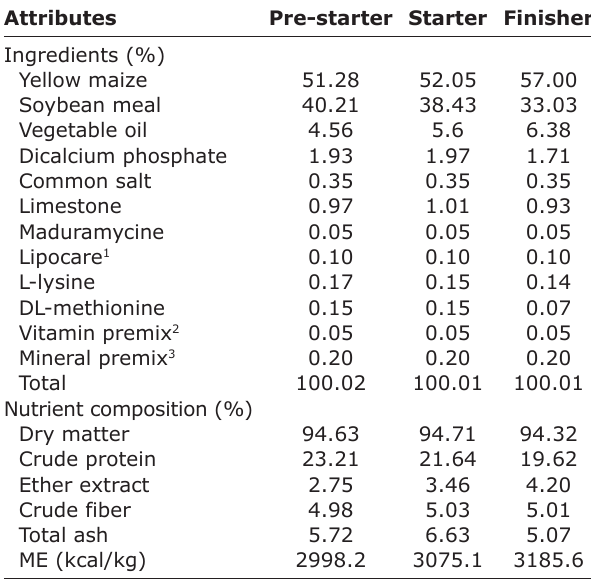
Table-1: Ingredients and chemical composition of basal diet used during experimental feeding.